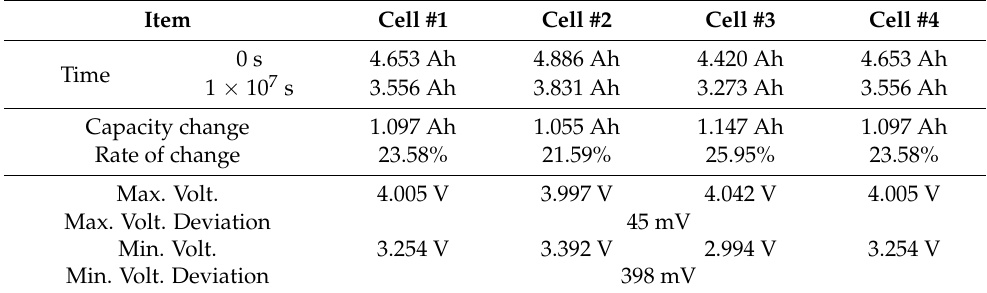
Table 3. Aging progress results of series connection with ± 5% capacity Table 4. Aging progress results of series-connected batteries with ±10% capacity deviation.